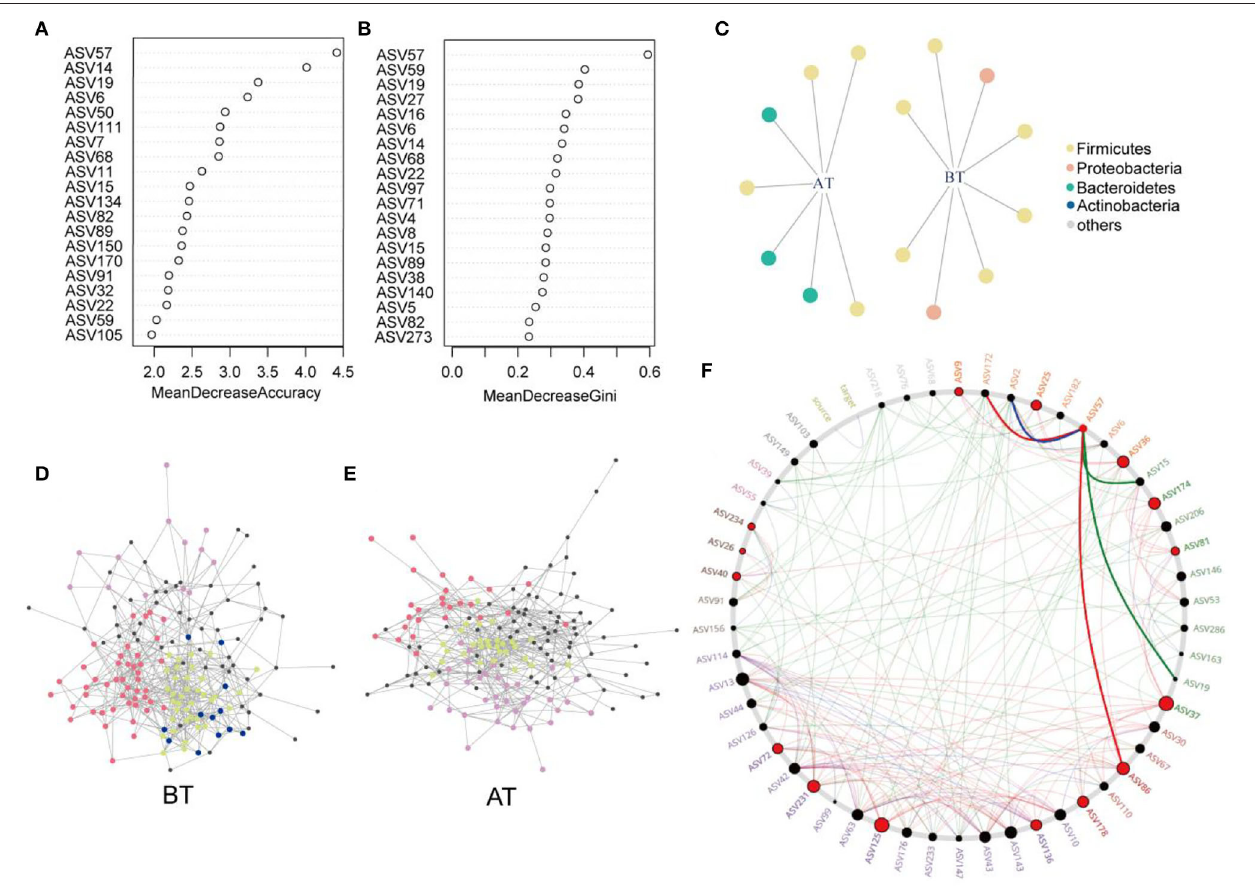
FIGURE 4 | Identification of core ASVs and microbial network analysis. (A,B) Random forest showing the top 20 features of the intestinal microenvironment distinguished in the pre- and post-treatment datasets. Each feature (ASV) was assigned two importance score of mean decrease accuracy (A) and mean decrease Gini (B) . (C) Bipartite network showed ASVs specific to before or after treatment identified using indicator species analysis in gut microbial communities. The circle indicates that single species are positively and significantly correlated ( p < 0.05) with one or more gut microenvironments (the link given by the line). Different ASVs belonging to same phylum level are given the common color. Co-occurrence sub-networks of (D) before treatment or (E) after treatment. Circles for microbial ASVs are represented by nodes. And partial nodes are colored by association with different modules, which include indicator species corresponding to different gut microenvironment. (F) Common sub-networks analysis of BT group and AT group. All nodes belonging to the same community were randomly assigned similar colors. Gray nodes represented ASVs appearing in both the variable group. Big and red node can be considered as “drive microbiota” Red line indicate only in the AT group of sub-networks of interactions. Green line indicates only in the BT group of sub-networks of interactions. And blue line expresses the interactions in both